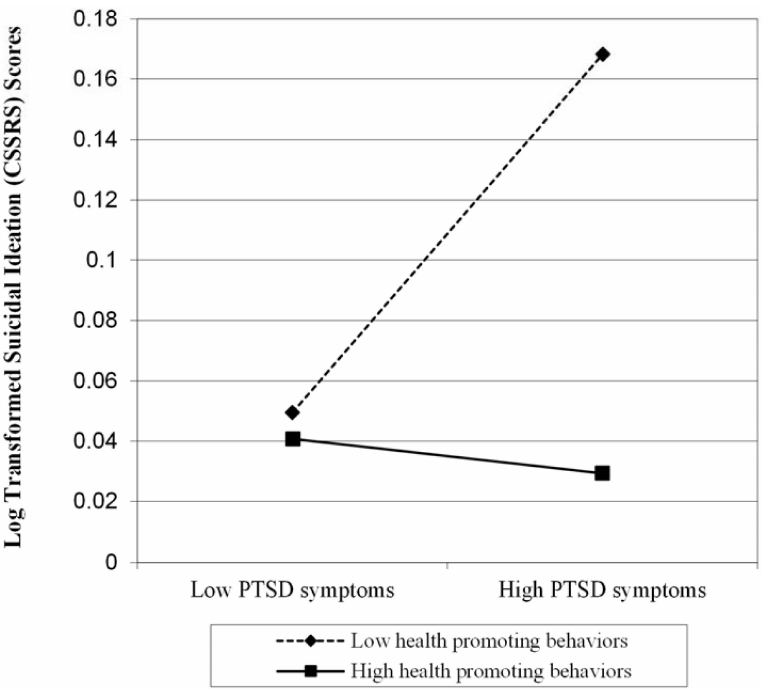
Fig 1. Plot of health promoting behaviors and PTSD symptoms interaction predicting suicidal ideation among Iraq/Afghanistan Veterans (N = 108). The dotted line reflects veterans who engagein health promoting behaviors infrequently,whilethe solid line represents veterans who frequently engagein health promoting behaviors. Log transformed suicidalideationscores are on the y axis and PTSD symptoms are on the x